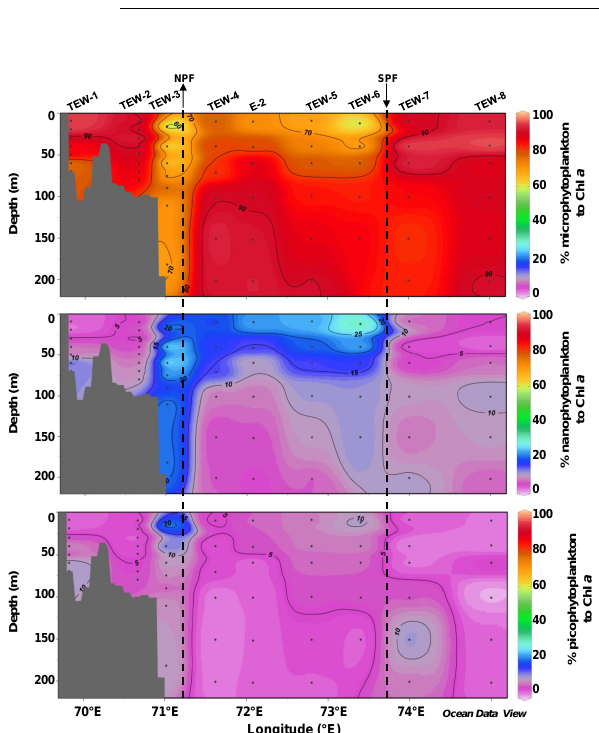
Figure 6. Figure 6. Vertical distribution of micro-, nano- and picophytoplank- ton community contributions to total biomass along the TEW tran- sect. The dashed lines represent the approximate location of the southern branch of the polar front going to the North (NPF) and to the South